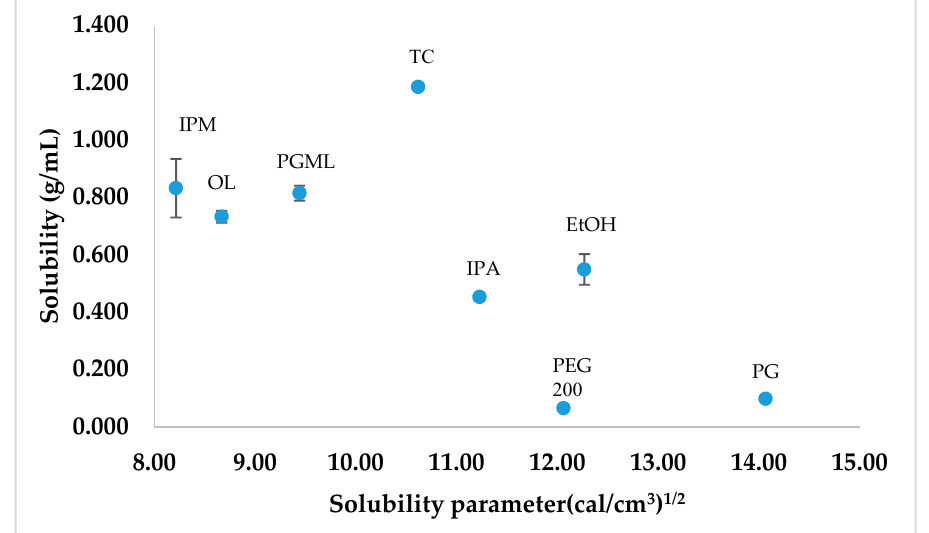
Figure 4. The calculated solubility parameters of different solvents plotted against the corresponding saturation solubility of TBF-free base at 32 ± 1 °C ( n = 3, mean ± SD).